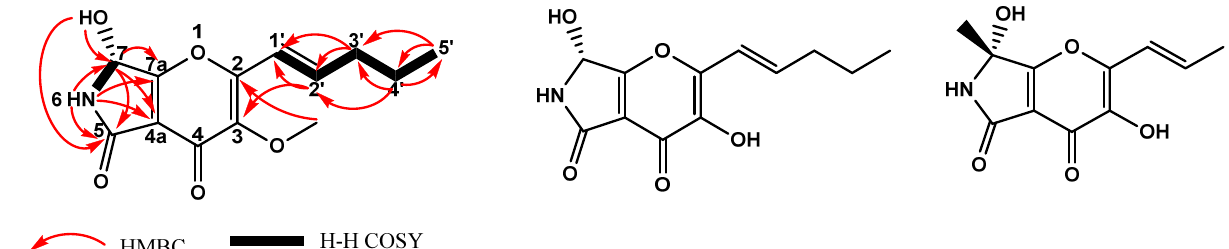
Figure 5. The key COSY, HMBC of pyranonigrin G ( S5 ) and structure of pyranonigrin F and A.